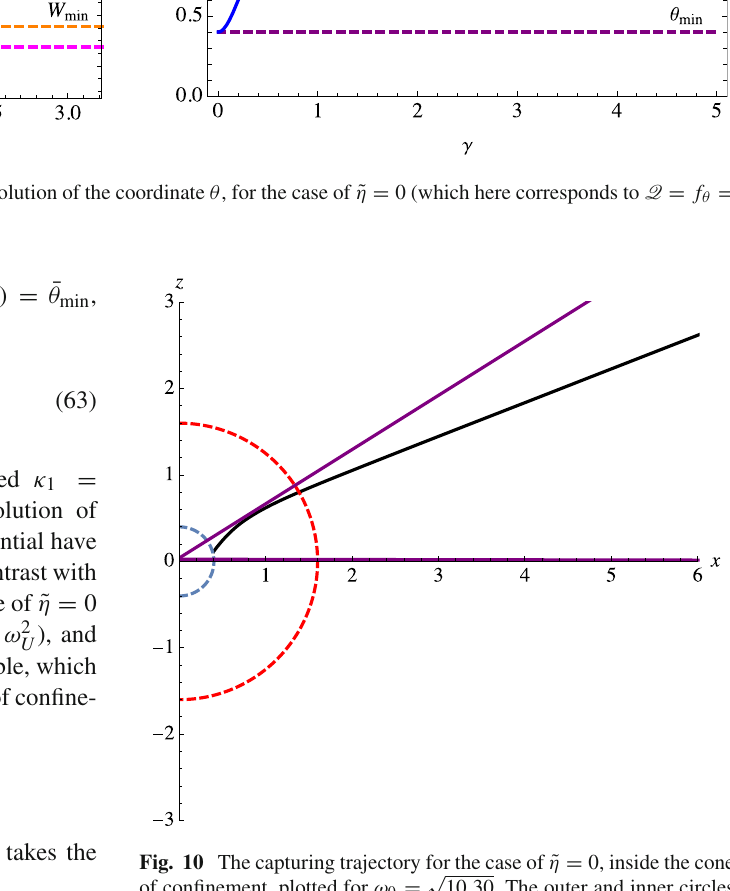
The corresponding particle-cone is therefore confined to ¯¯ θ min